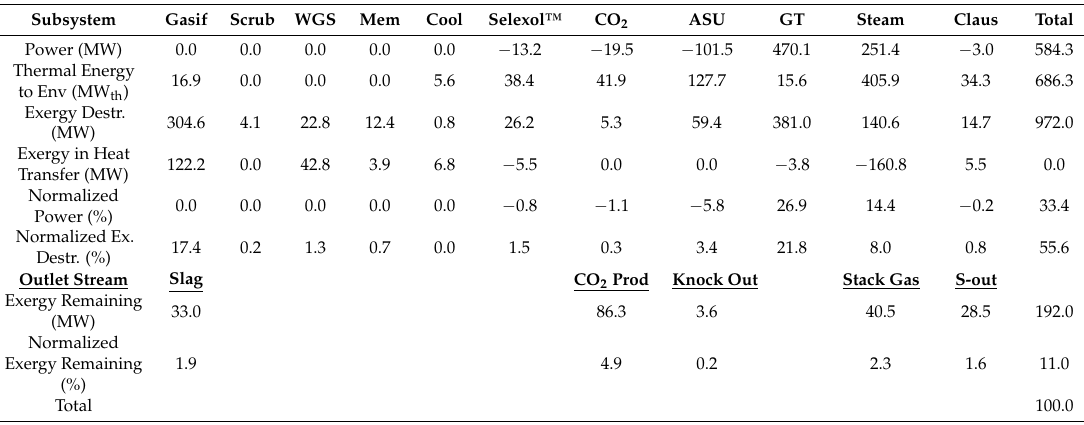
Table 7. Hydrogen membrane model results, assigning all exergy destruction associated with heat transfer between subsystems to the Steam